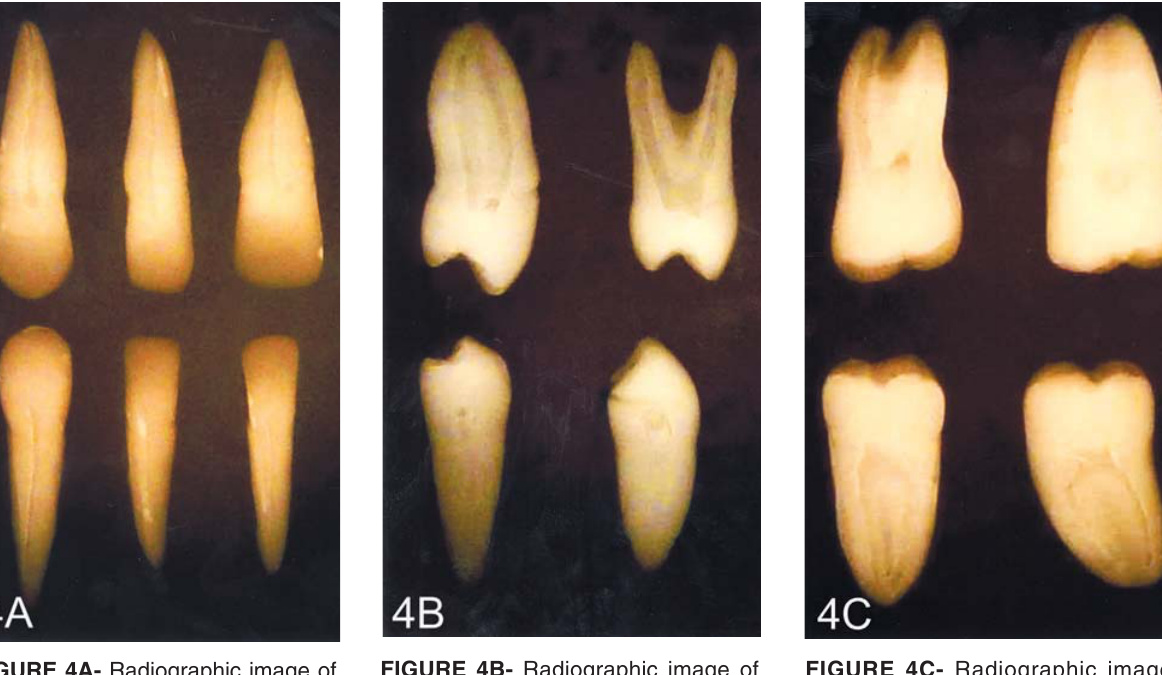
FIGURE 4A- Radiographic image of cloudy resin anterior teeth